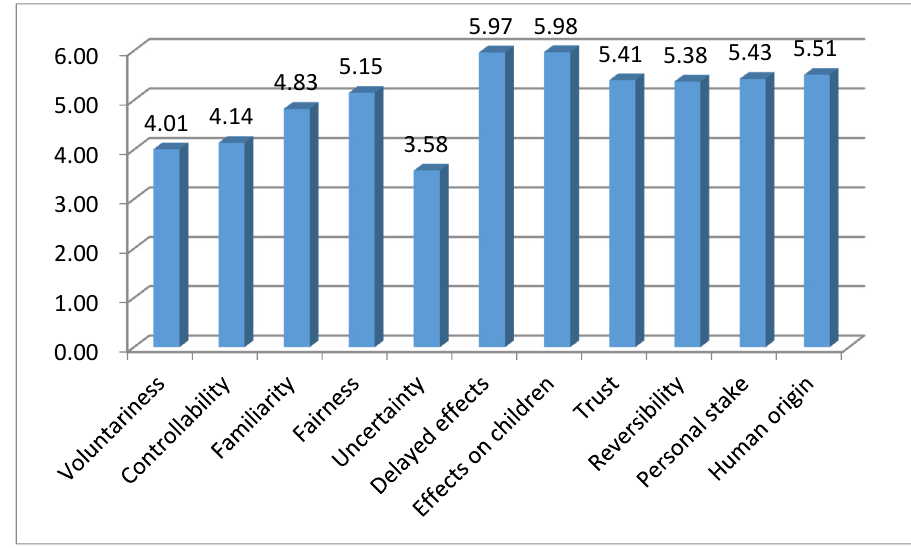
Figure 1. The perceived outrage factors regarding climate change.